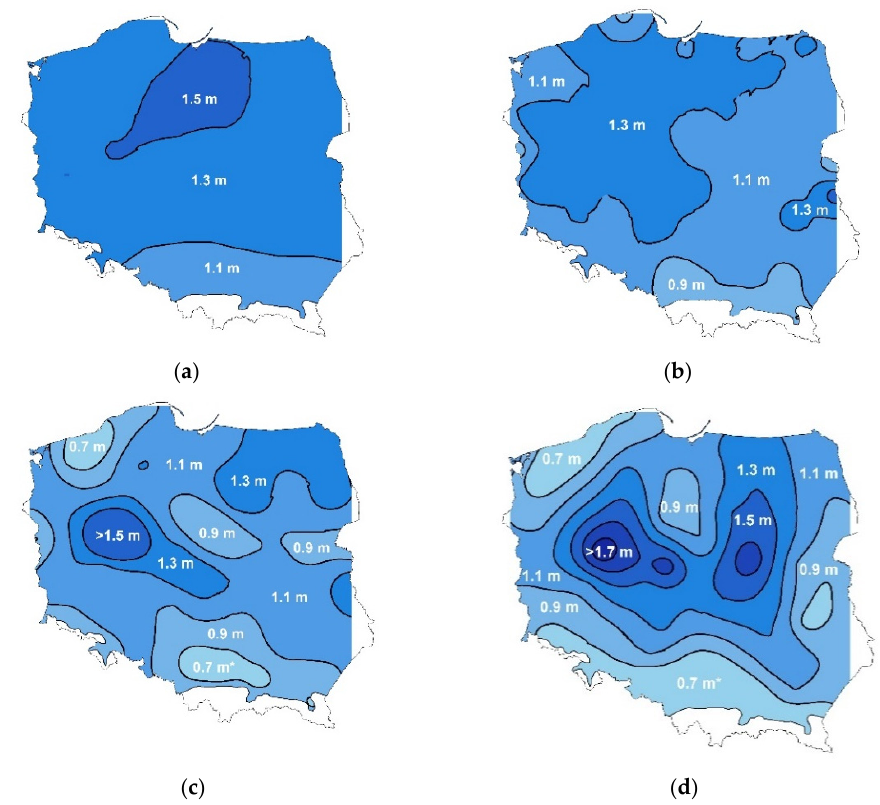
Figure 13. Changes in ground freezing zones in Poland over the last 50 years. ( a ) Years 1981–1990. ( b ) Years 1991–2000. ( c ) Years 2001–2010. ( d ) Years 2011–2020.